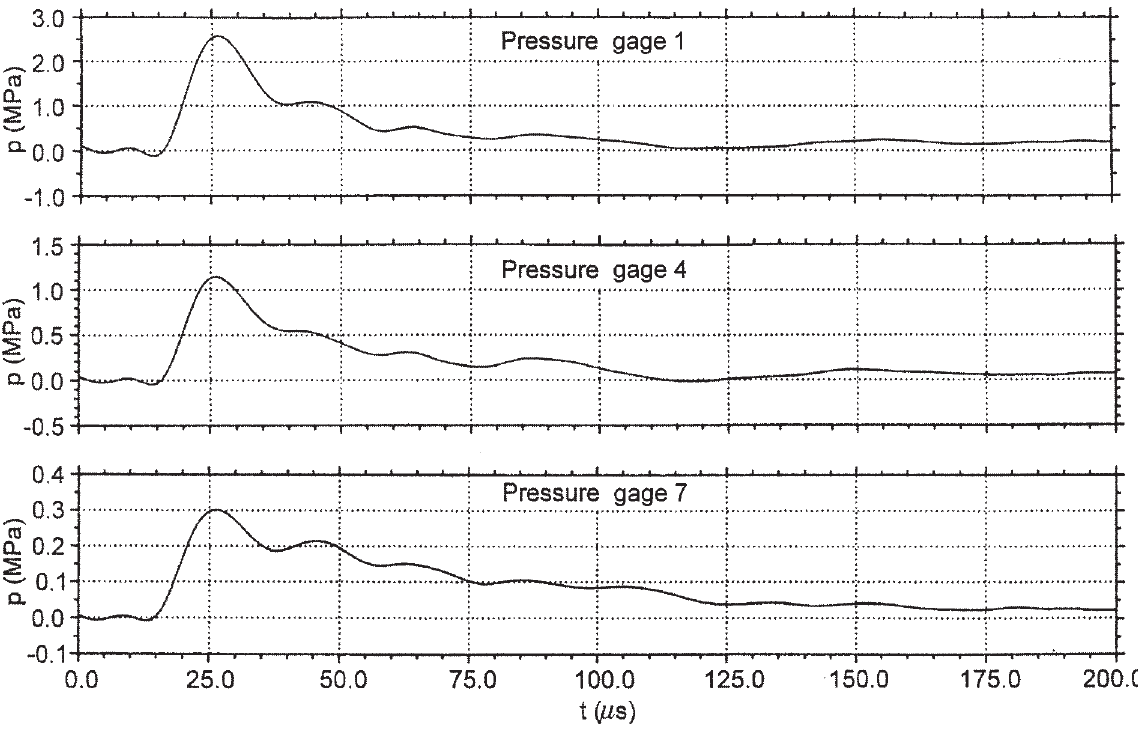
Fig. 10. Average free field filtered shock wave pressure pulse measured at different distances: pressure gage 1, 1100 mm; pressure gage 4, 2100 mm; pressure gage 7, 5095